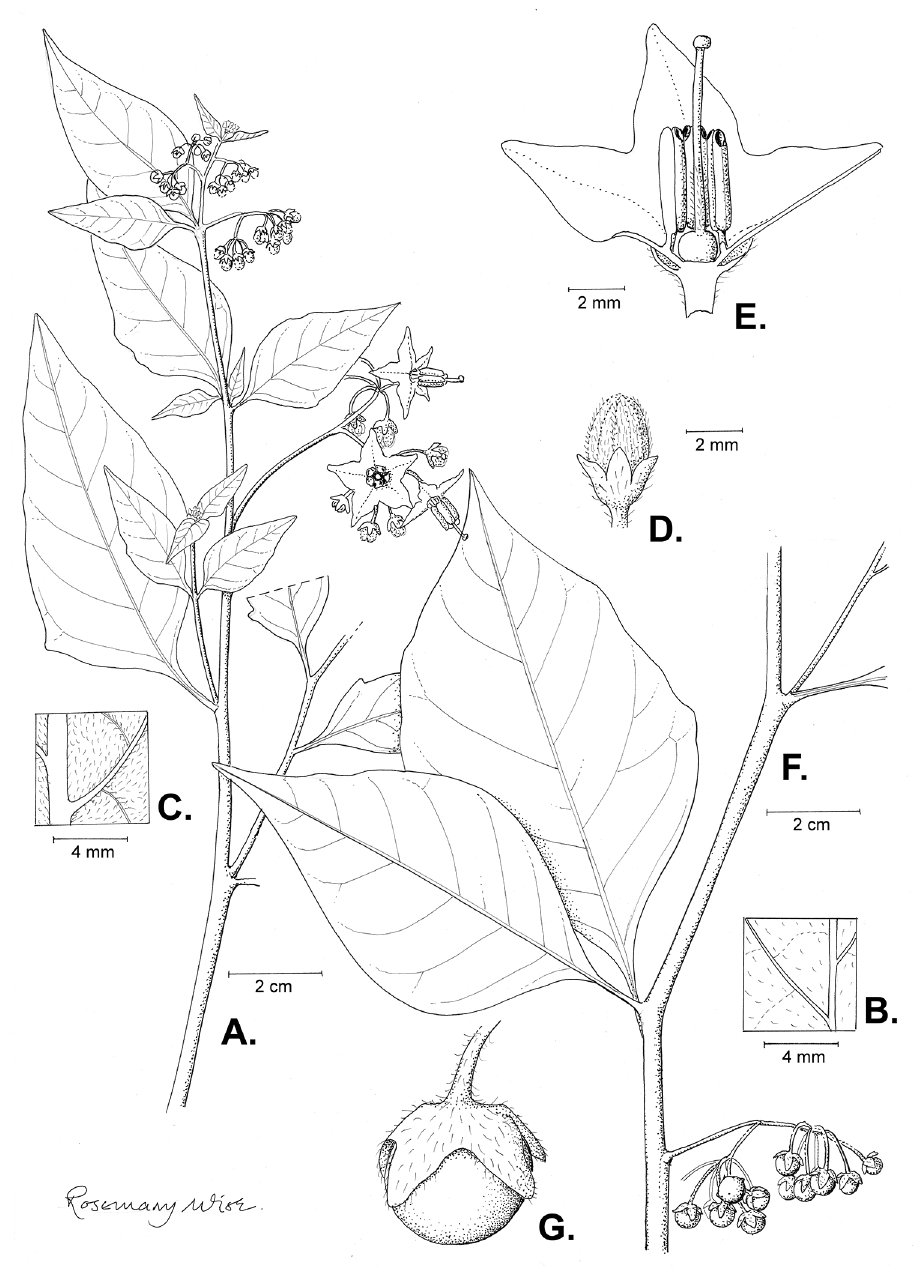
Figure 18. Solanum furcatum Dunal A Habit B detail of adaxial leaf surface C detail of abaxial leaf sur- face D Bud E dissected flower F detail of infructescence G fully mature fruit ( A–G Särkinen et al. 4095 ). Drawing by R. Wise (previously published in “PhytoKeys